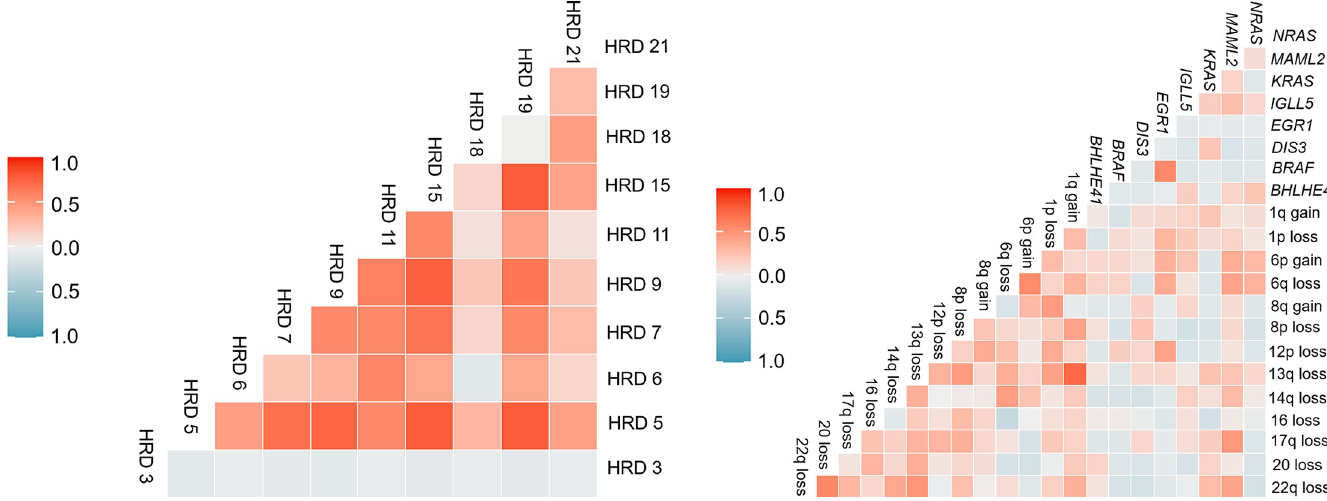
Fig 3. Pairwise associations between mutations and copy number variations. (A) In patients with hyperdiploid multiple myeloma, chromosome 5 variations were correlated with variations in chromosomes 9, 15, and 19, while chromosome 15 variations were correlated with variations in chromosomes 9 and 19. (B) Among patients without hyperdiploid multiple myeloma, 1q gain was correlated with 13q loss, BRAF mutation was correlated with EGR1 mutation, and MAML2 mutation was correlated with 17q loss.